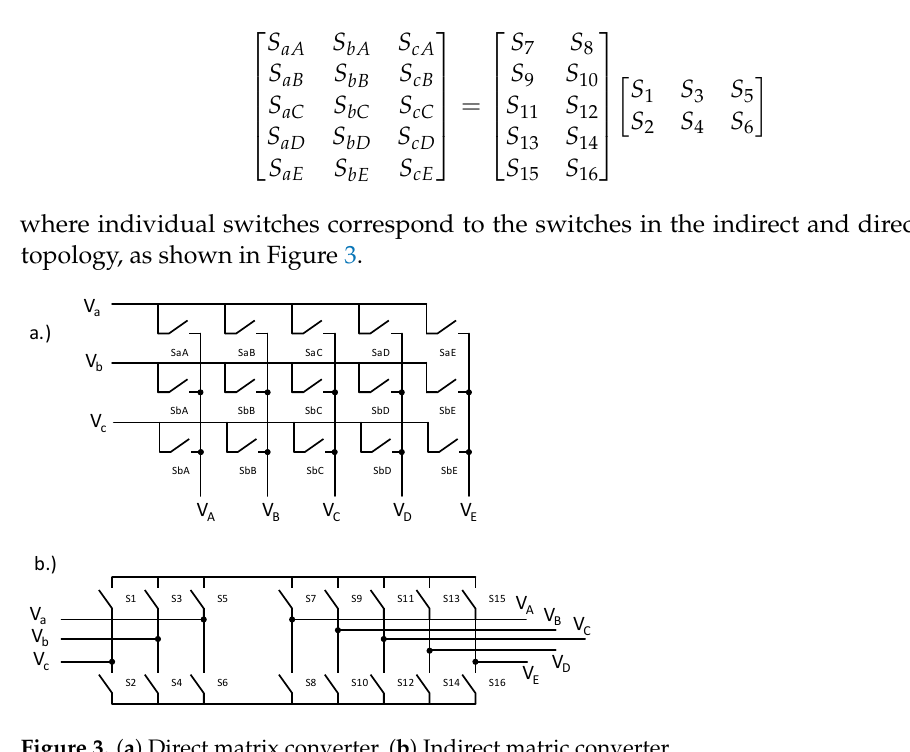
Figure 3. ( a ) Direct matrix converter, ( b ) Indirect matric converter.